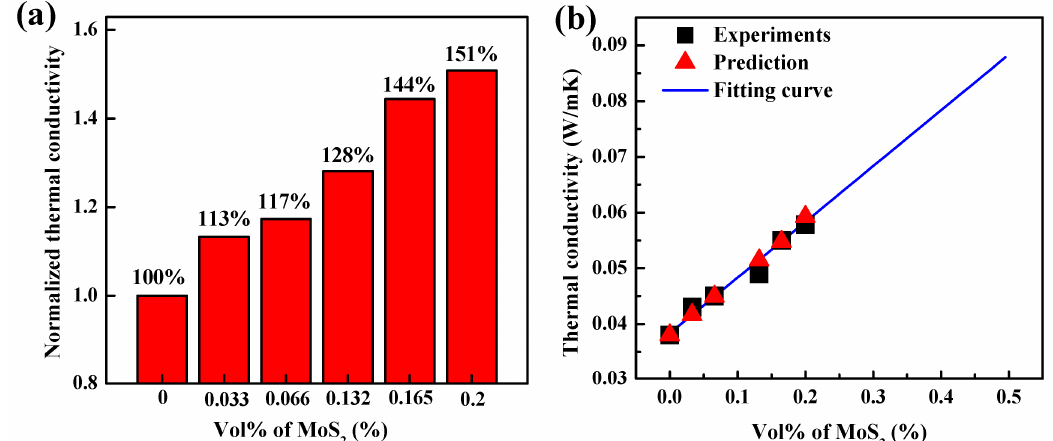
Figure 5. Thermal transport properties of composite GAs. ( a ) Normalized thermal conductivity of composite GAs with different volume factions of MoS 2 ; ( b ) the calculated thermal conductivity of composite GAs from the effective medium theories (EMTs) showed an excellent agreement with the measured values. The fitting curve was plotted according to the obtained values from the EMTs.